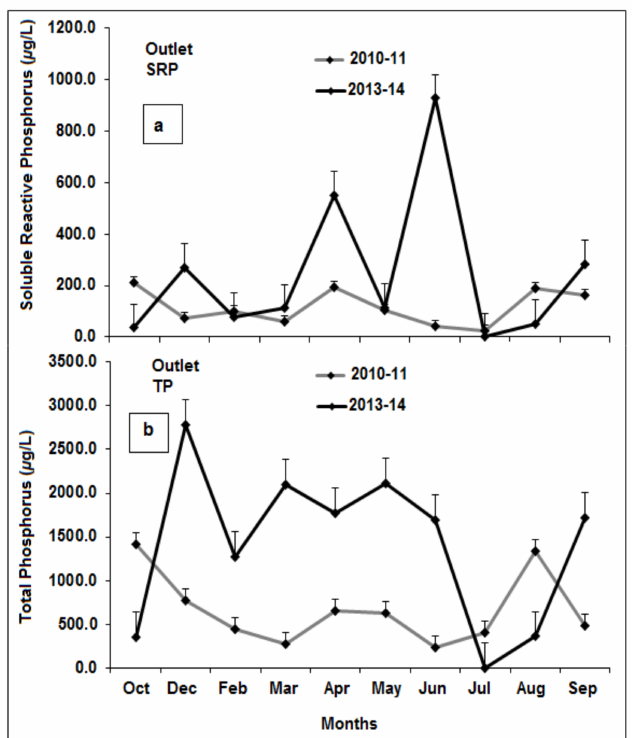
Figure 11. Soluble reactive phosphorus (SRP) and total phosphorus (TP) concentrations ( µ g/L) measured at the lagoon outlet for common sampling dates during ( a ) 2010–2011 and ( b ) 2013–2014. Overall population mean concentrations of outlet TP, for 2013–2014 (1573.0 µ g/L) were significantly greater than for 2010–2011 (703.1 µ g/L) using one-way ANOVA ( p = 0.011) and paired t-tests ( µ 1 > µ 2 ) ( p = 0.025) (Figure 11). Moreover, comparisons of